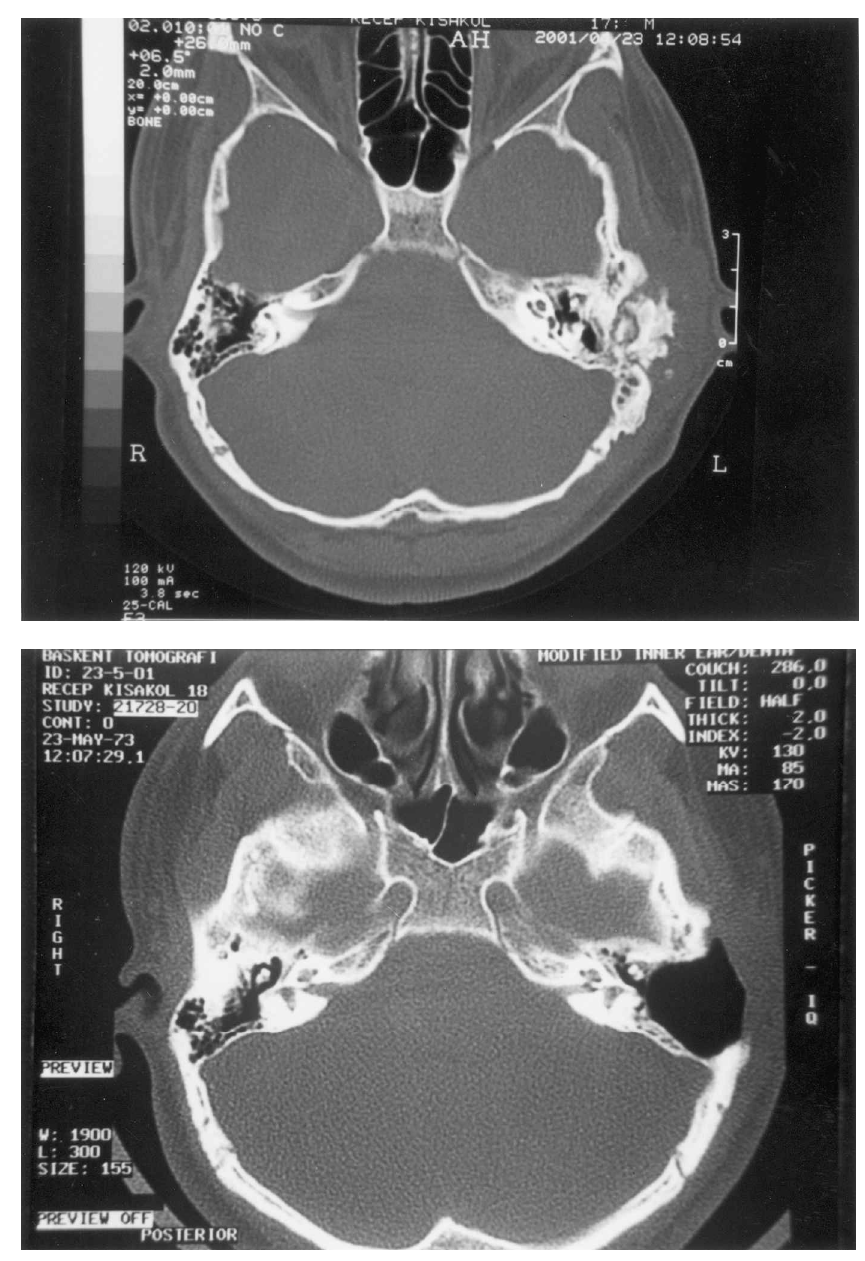
Fig. 1. Computed tomography of temporal bones showed a mass of soft tissue that contained bone fragments, obliterating external auditory meatus and subcutaneous fatty tissue: destruction of mastoid bone and the loss of aeration in mastoid cells on the left side (a) and the cavitation in mastoidal bone after surgery